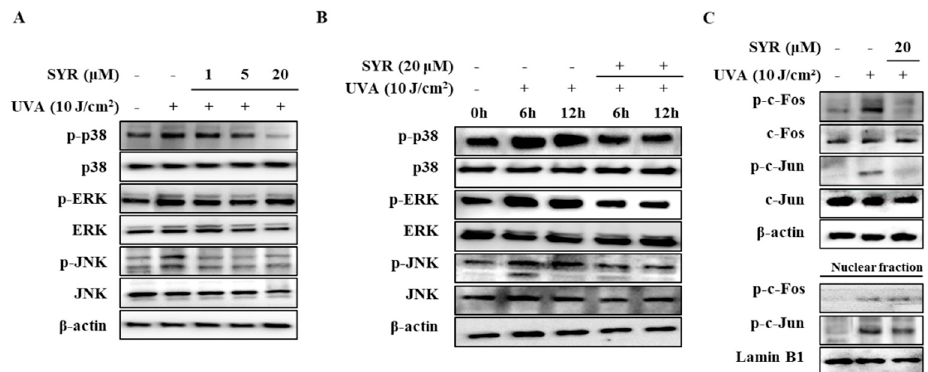
Figure 3. Effect of SYR on the total and phosphorylated (p-) protein levels of MAPK/AP-1 signaling effectors in UVA-irradiated HaCaT keratinocytes. Total cell lysates and nuclear extracts of the cells were used to determine the protein levels of phosphorylated (p-) and inactive forms of ( A, B ) MAPKs (p38, ERK and JNK), ( C ) c-Fos and c-Jun proteins by Western blotting. Cells were exposed to UVA radiation (10 J/cm 2 ) and treated with or without given concentrations of SYR for 24 h ( A , C ), 6 h and 12 ( B ). β -Actin was used as an internal control for Western blotting. Lamin B1 was used as an internal control for nuclear fraction Western blotting.